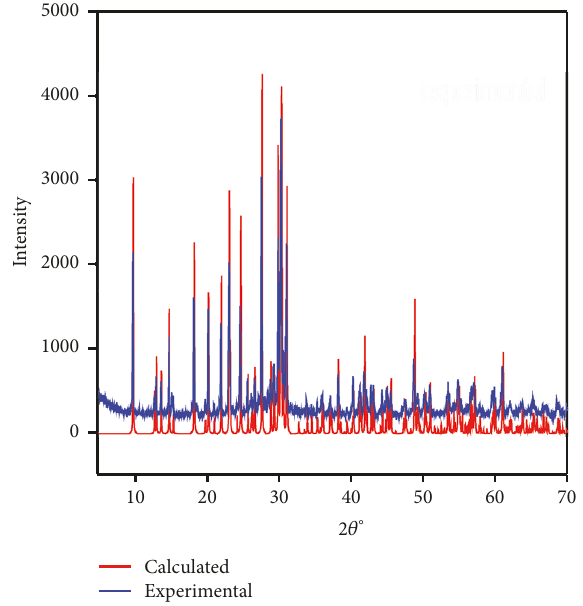
Figure 1: Calculated and experimental powder X-ray diffraction patterns of Na 2 K 2 Cu(MoO 4 ) 3